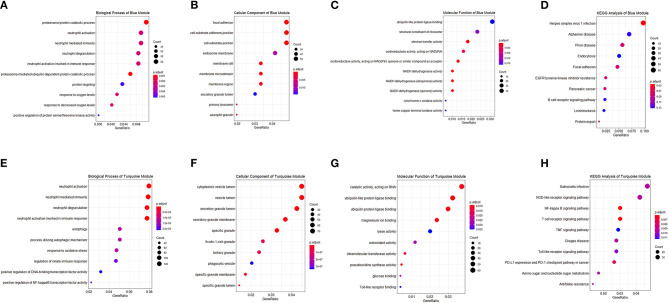
Functional enrichment analysis of module genes. Module genes in the blue and turquoise modules were analyzed, and enrichment categories of two modules are shown in (A,E) biological process, (B,F) cellular component, (C,G) molecular function, and (D,H) KEGG pathway, respectively. The dot size represented the count of differentially expressed genes, and the color depth represented the p-value-based significance.